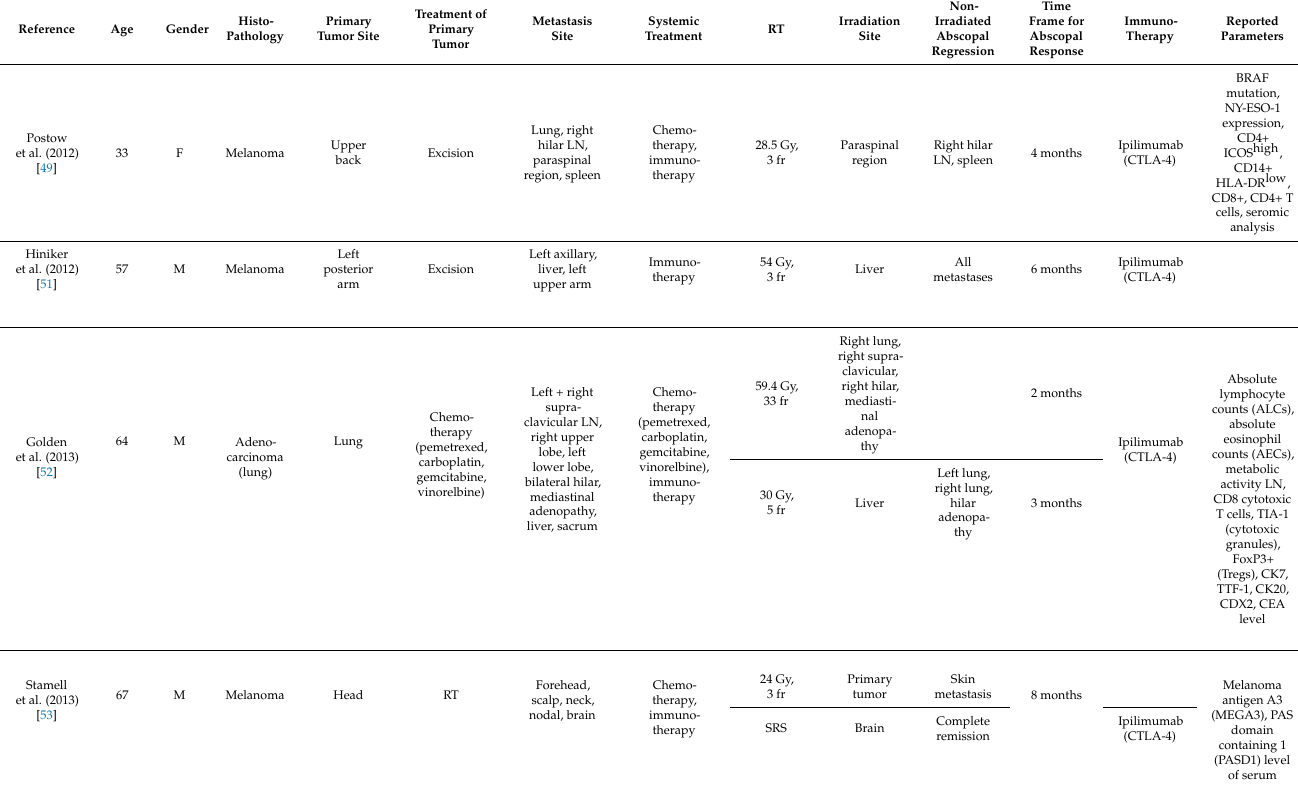
Table 2. Abscopal effect case reports with